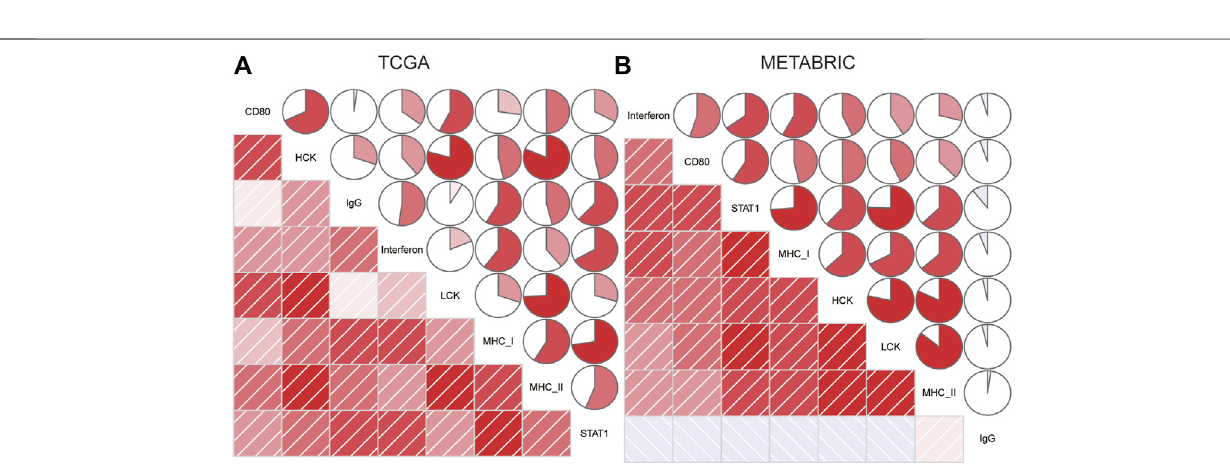
Frontiers in Pharmacology |